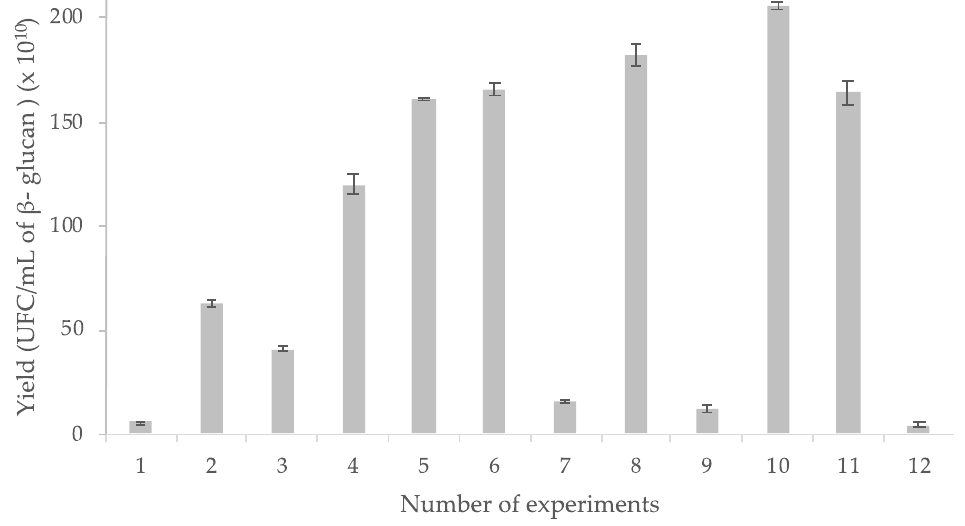
Figure 3. Proteolytic activity of L. rhamnosus GG in fermentation with β -glucan according to condi- tions of the experimental design.